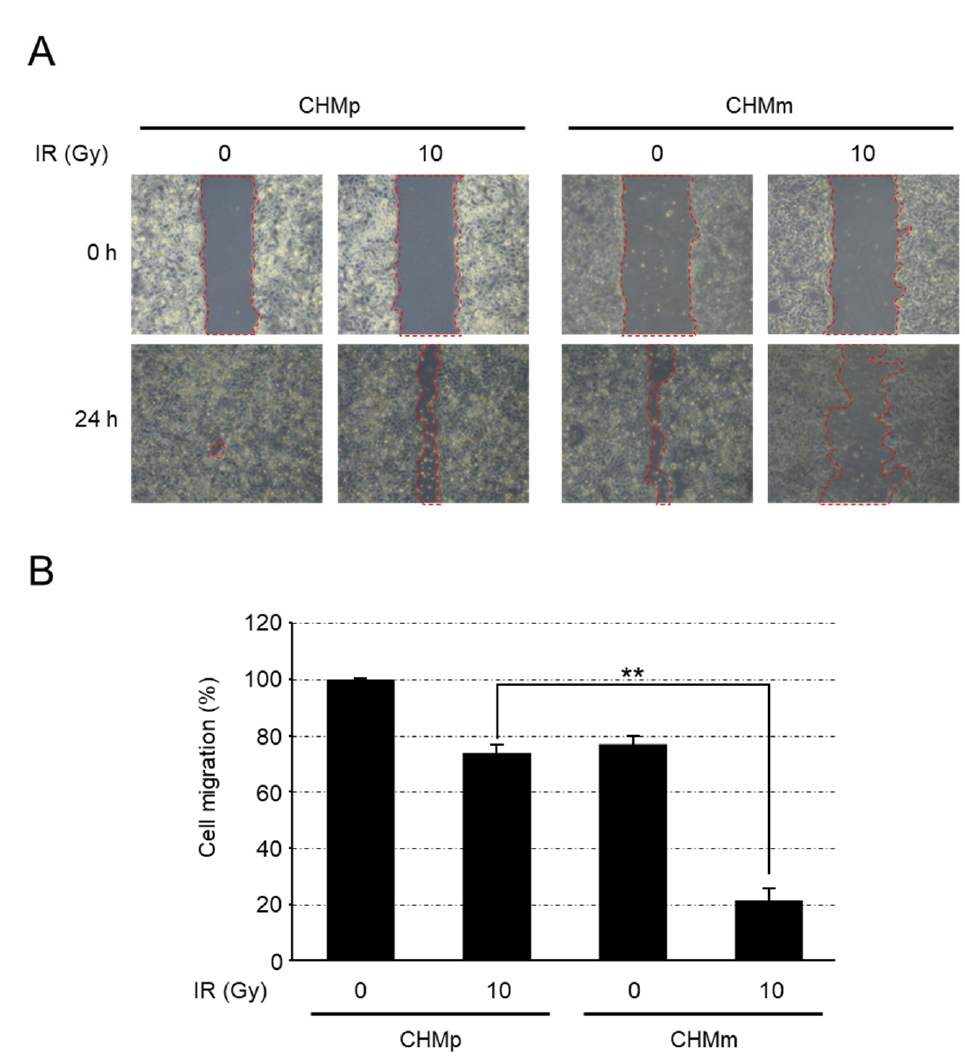
Figure 3. Cell migration after irradiation of CHMp and CHMm. ( A ) Migration of CHMp and CHMm cell lines that were incubated for 72 h after irradiation was assessed using a wound healing assay 24 h after scratch. Representative images of the scratched areas are shown. Microscope magnification, × 200. ( B ) Cell migration was quantified using ImageJ software. The values of cell migration of CHMp without irradiation are 100%, and the values are shown from three independent experiments as the mean ± SD. Asterisks on top of the brackets indicate significant differences calculated using ANOVA with Tukey’s multiple-comparison test (** p <